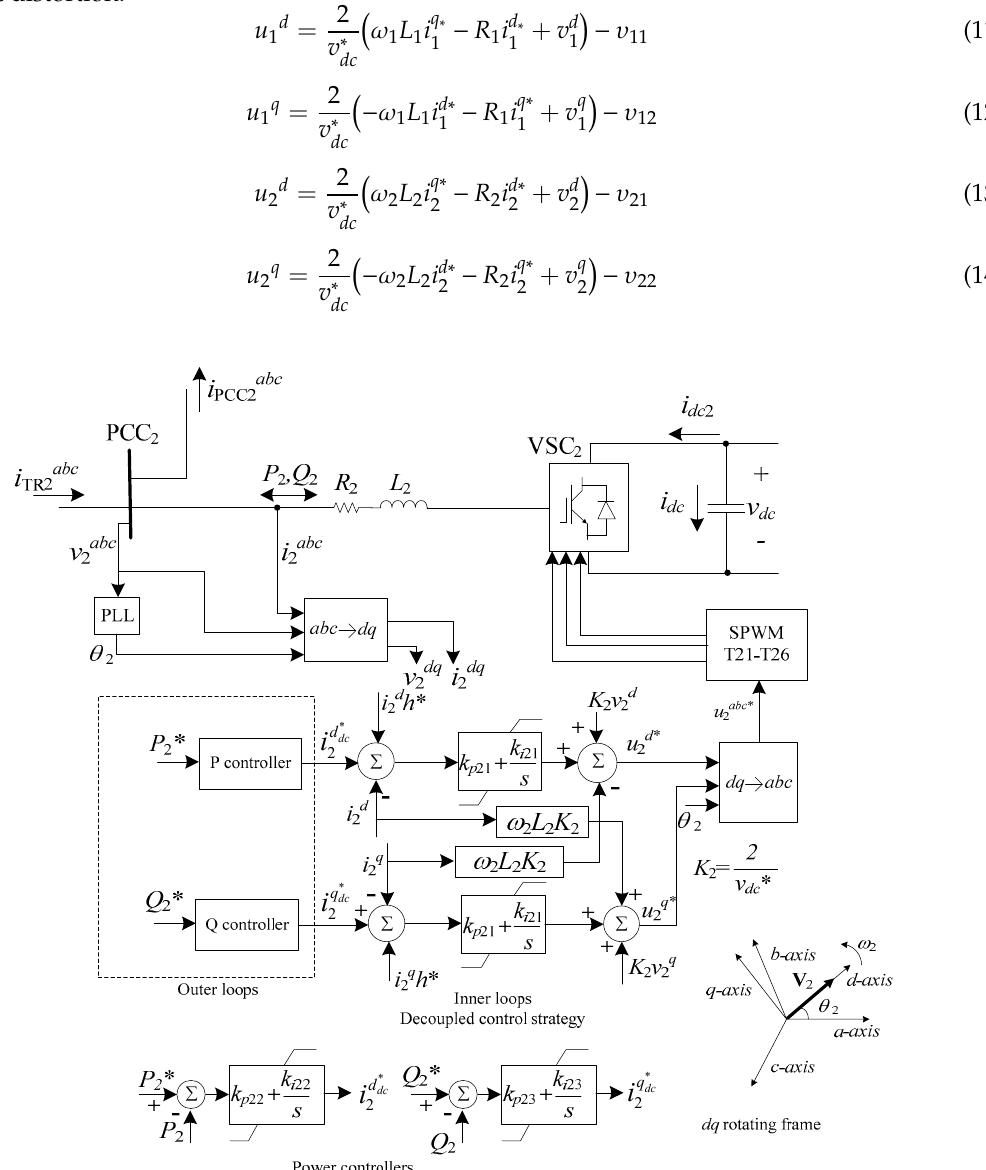
Figure 6. Control block diagram for VSC 2 .